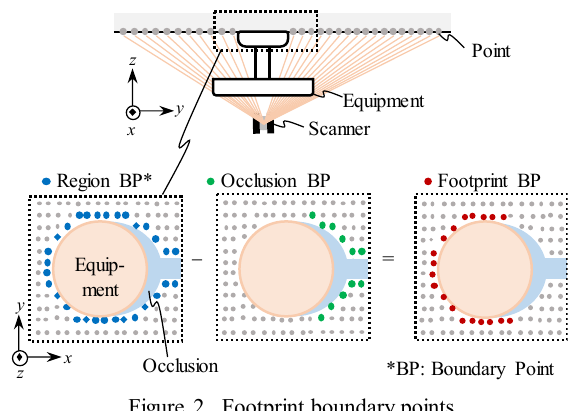
Figure 2. Footprint boundary points